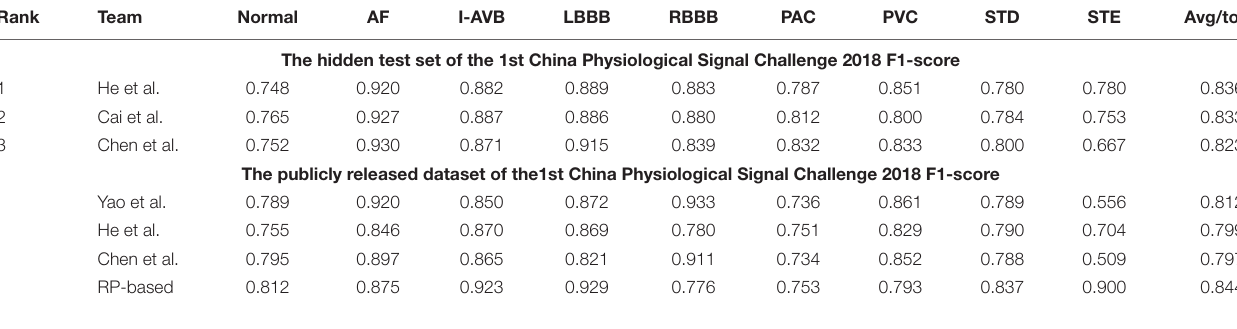
TABLE 5 | The performance of the published 1D ECG-based works and the proposed method.